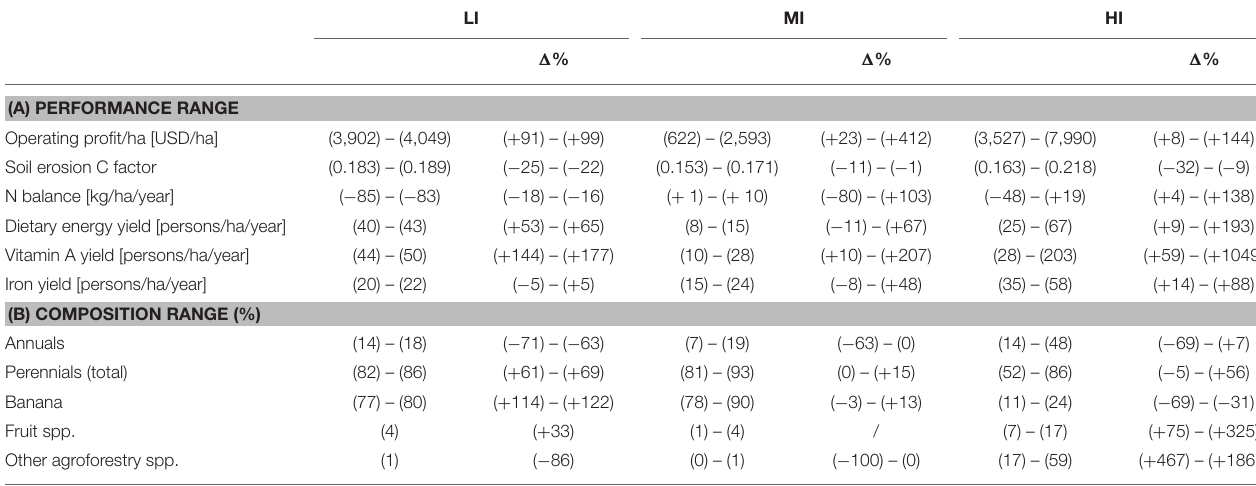
TABLE 4 | Performance range ( A ) and composition range ( B ) of the redesigns outperforming the original farm, as calculated by the FarmDESIGN model, and the percentage change in objective ( A ) and farm components ( B ) relative to the original farm